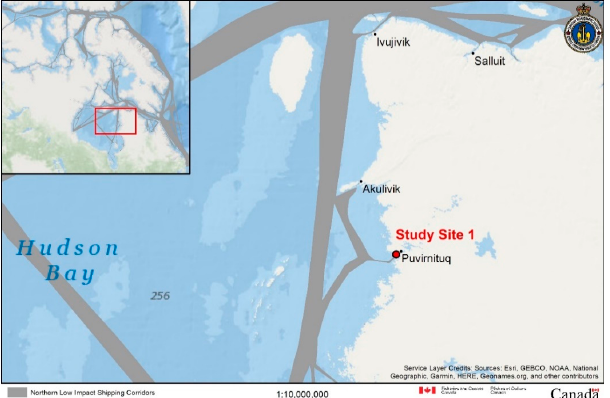
Figure 2. Location of Study Site 1, near Puvirnituq, Quebec.